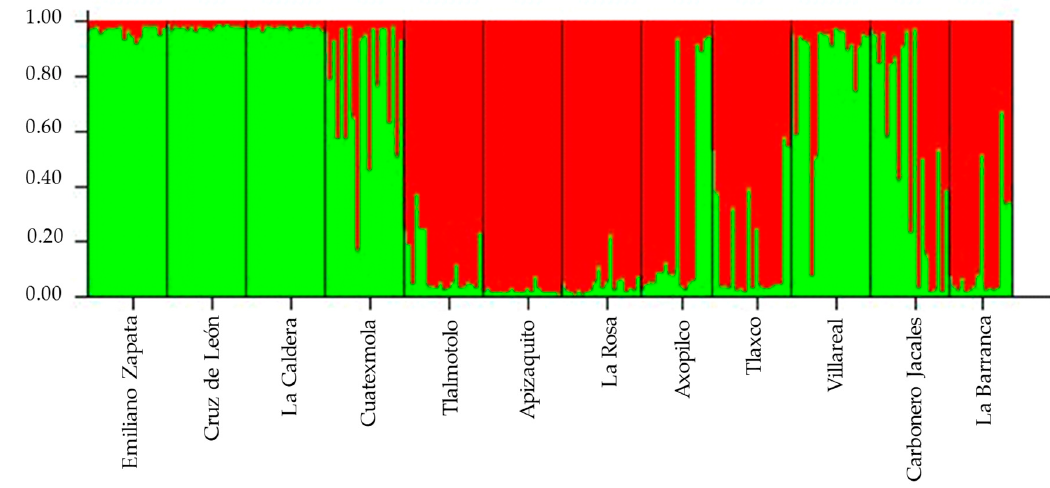
Figure 5. Graphic representation of the genetic structure of the Pseudotsuga menziesii (Mirb.) Franco populations analyzed. Each column represents each of the populations. The K groupings are indicated by colors. The numbers on the axis indicate the coefficient of ancestry of the populations.